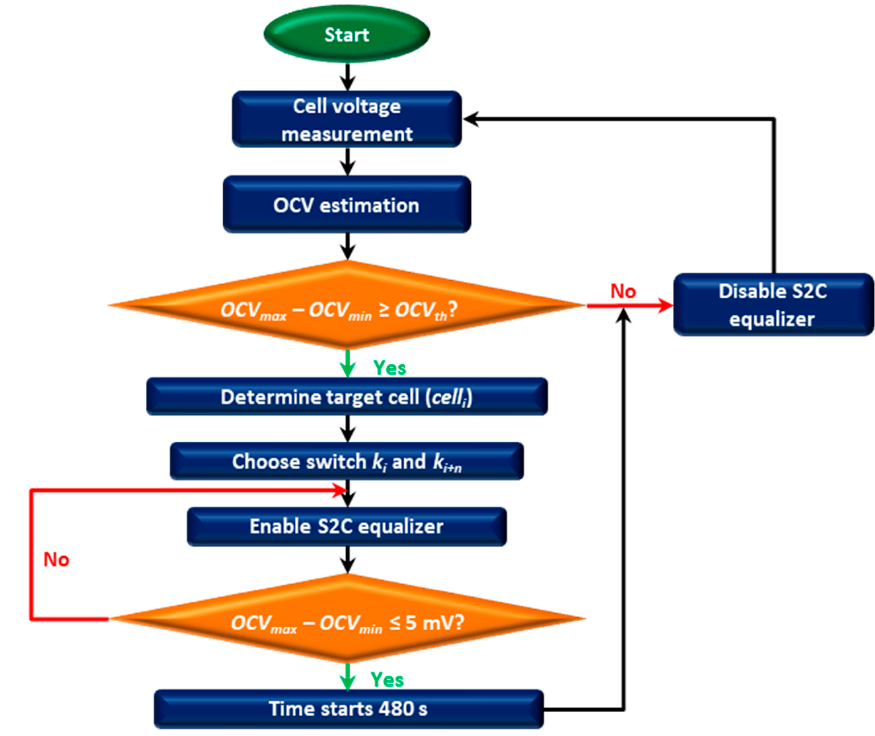
Figure 7. Flowchart of string-to-cell battery equalization algorithm.